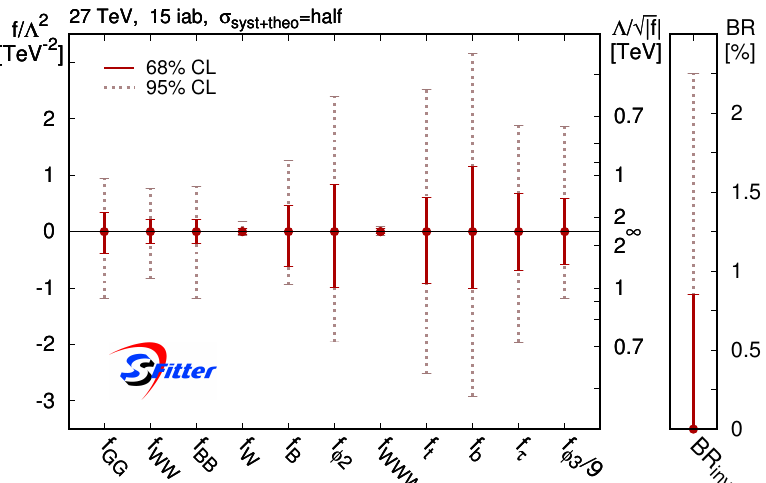
Figure 4: Result from the global Higgs analysis in terms of dimension-6 operators, complementing the high-luminosity and improved-error scenario of Fig. 2 with re- sults for 95% C.L. or two standard